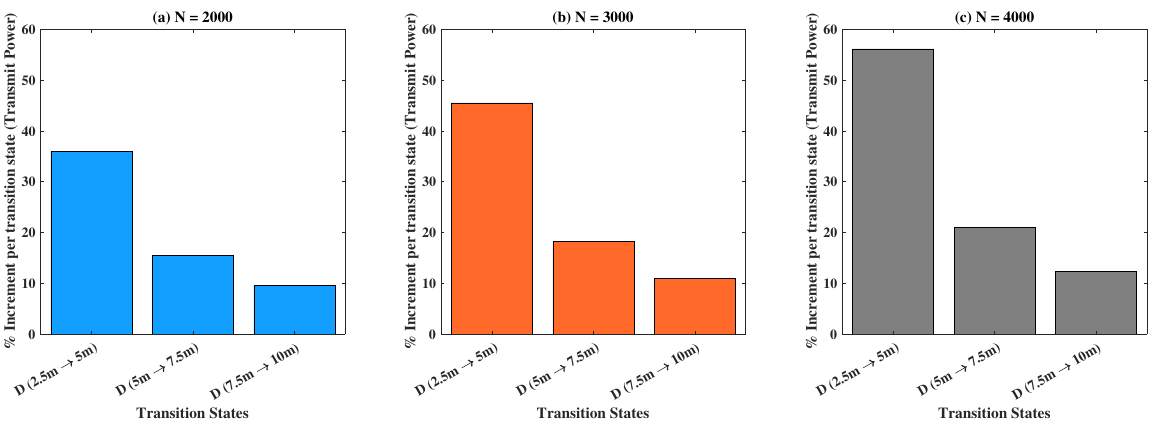
Figure 9. Percentage increment in transmit power versus different transition states pertaining to D for: ( a ) N = 2000, ( b ) N = 3000, and ( c ) N =